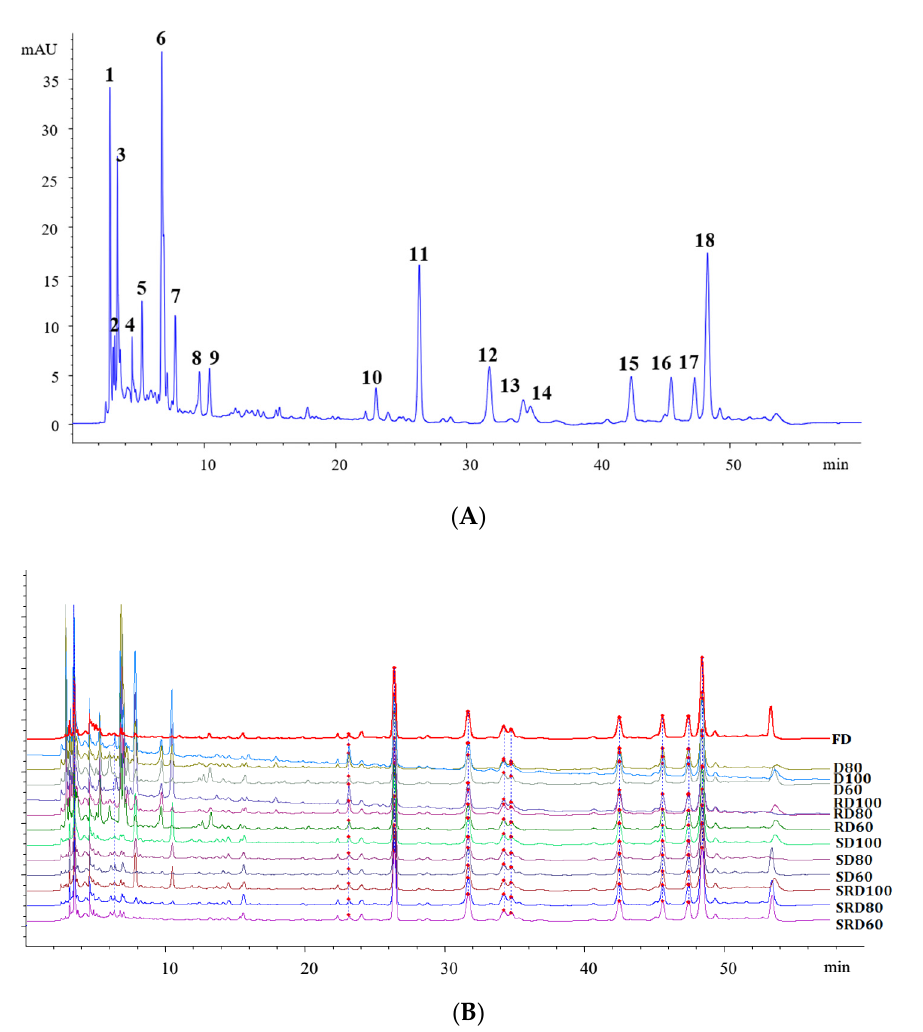
Figure 4. Fingerprinting analyses of Dendrobium catenatum leaves: ( A ) representative HPLC chro- matogram ( B ) and chromatograms obtained after exposure to various processing methods.